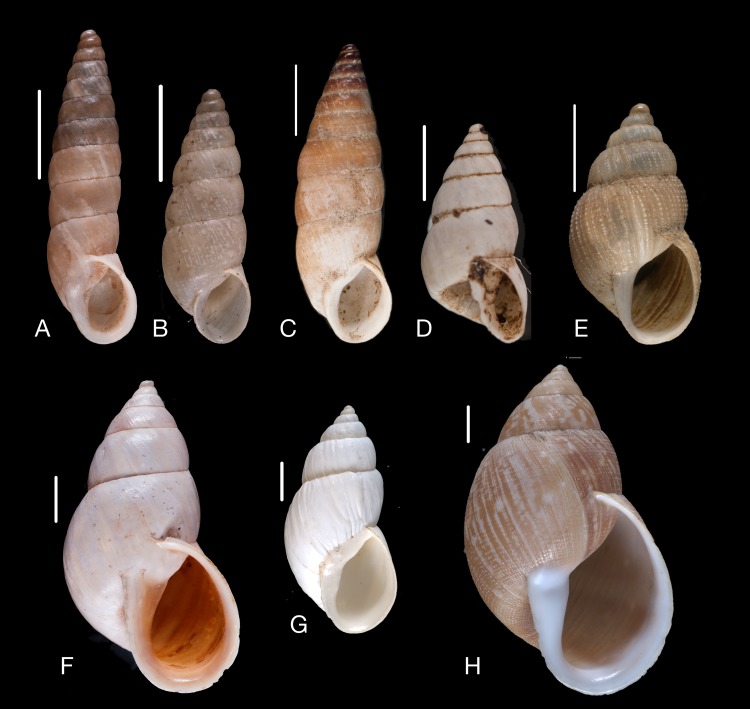
Material collected by the CCP.(A–H) Bulimulidae. Bostryx lactifluus (Pfeiffer, 1857), MNCN 15.05/13089, (A) ventral view; Bostryx leucostictus (Philippi, 1856), MNCN 15.05/14540, (B) ventral view; Bostryx pupiformis (Broderip in Broderip & Sowerby I, 1832), MNCN 15.05/13190, (C) ventral view; Bostryx umbilicaris (Souleyet, 1842), MNCN 15.05/14515, (D) ventral view; Bostryx pustulosus (Broderip in Broderip & Sowerby, 1832), MNCN 15.05/14618, (E) ventral view; Bostryx rhodolarynx (Reeve, 1849), MNCN 15.05/3112, (F) ventral view; Bostryx mejillonensis (Pfeiffer in Pfeiffer & Dunker, 1857), MNCN 15.05/13141, (G) ventral view; Bostryx rouaulti (Hupé in Gay, 1854), MNCN 15.05/13309, (H) ventral view. Scale line 5 mm.